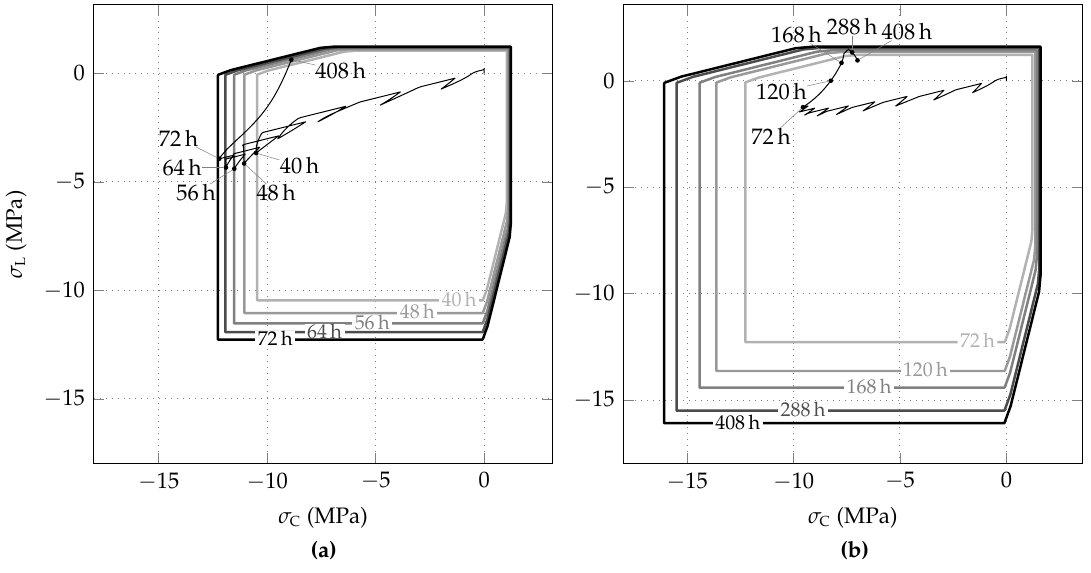
Figure 11. Evolution of biaxial strength envelopes of shotcrete and stress paths, predicted by the Schädlich model for initial stress release ratios of ( a ) 85% and ( b )